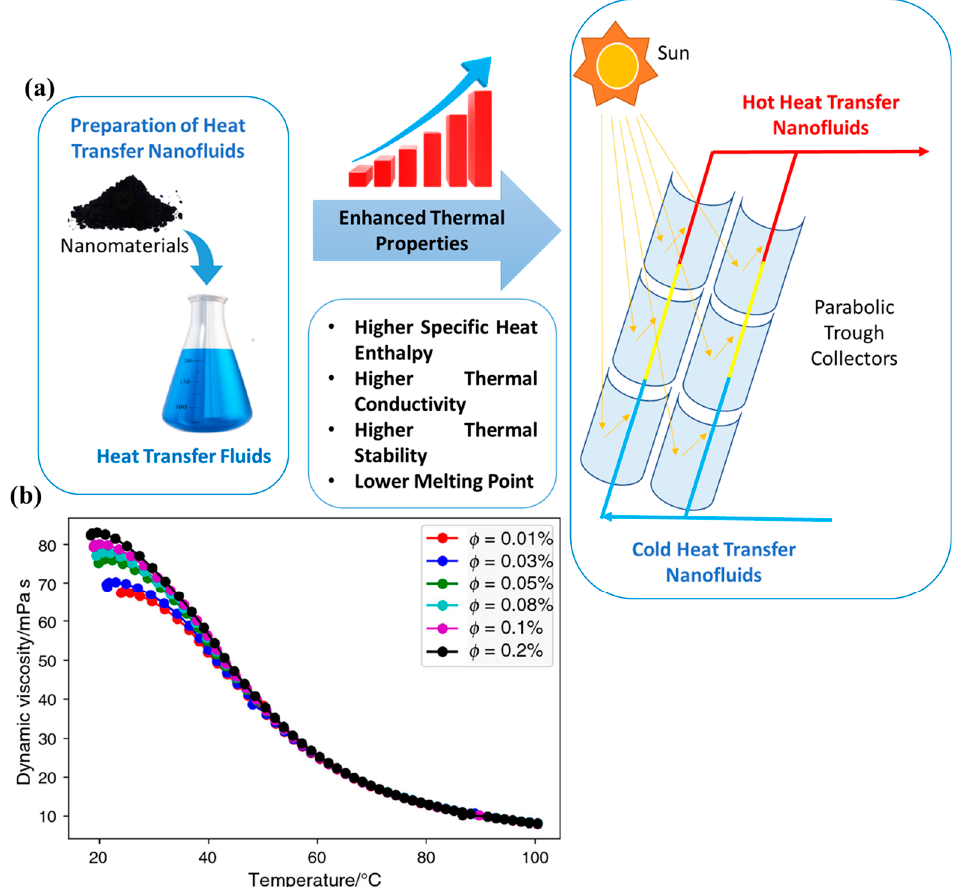
Figure 1. ( a ) Schematic illustration of the parabolic trough and heat transfer fluid collector; ( b ) experimental values of dynamic viscosity at various concentrations and temperatures [34].